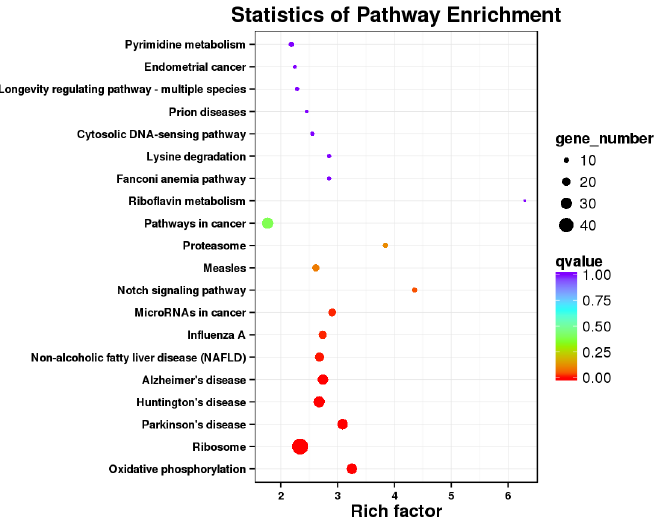
Figure 5. KEGG pathway analysis of DEGs in the E. coli and E. coli +pBD2 groups.